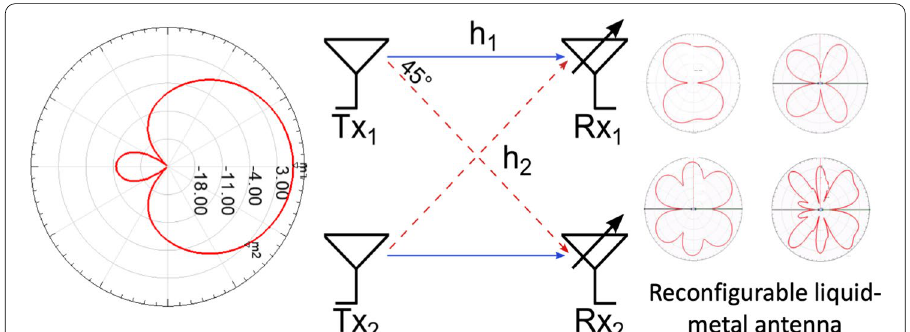
Fig. 7 Antenna model. Gaussian interference channel model with a static transmit (Tx) antennas and reconfigurable receive (Rx) antennas, used for simulating various states